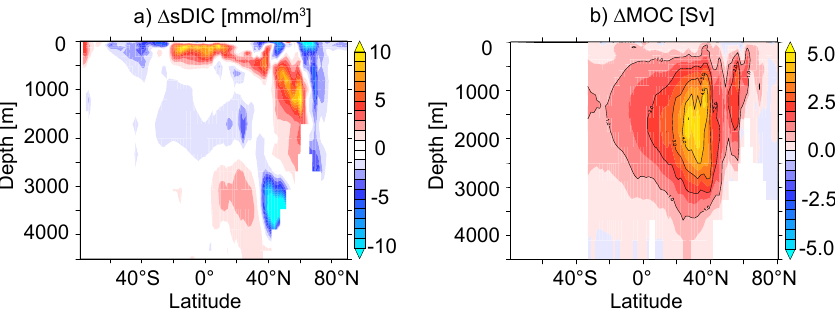
Fig. 12. Meridional section through the Atlantic Ocean including the Arctic Ocean showing the simulated zonal mean differences in (a) s DIC and (b) the meridional overturning circulation between the Pin.10x case and the control simulation averaged over the last 5yr (16–20yr). Contours in (b) are every